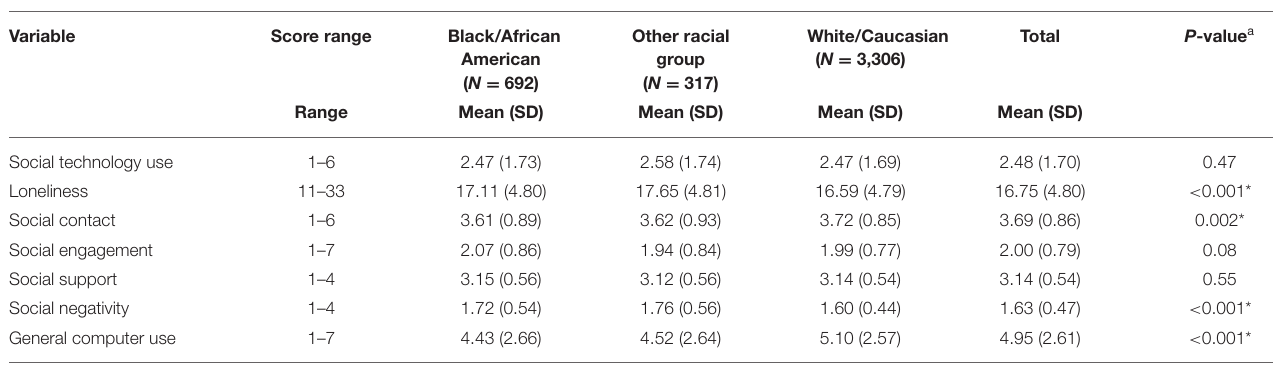
TABLE 2 | Descriptive information for primary study variables stratified by race and rurality ( N = 4,315). Stratification by race